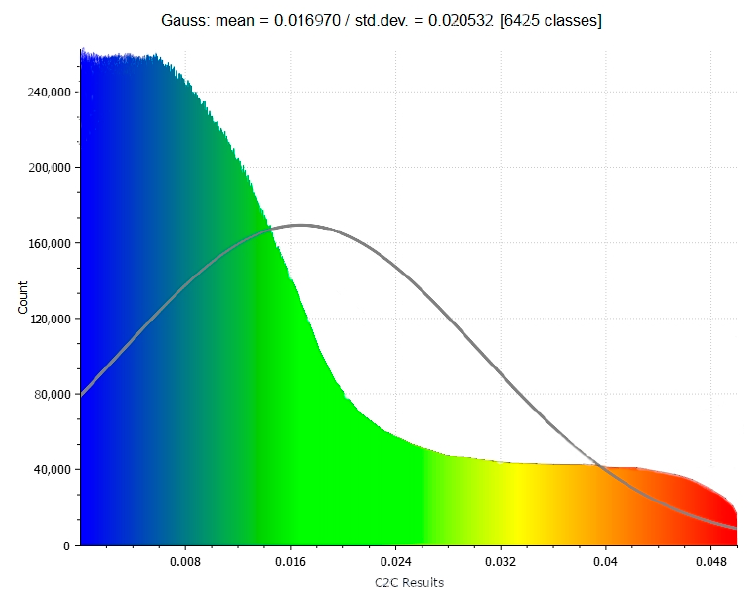
Figure 10. Cloud to cloud comparison (absolute distance calculation using Quadratic algorithm from CloudCompare).